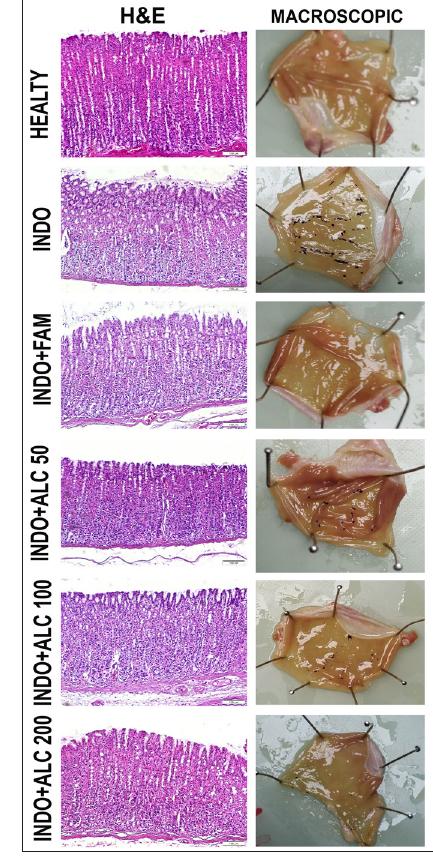
Figure 2. Macroscopic and histopathological